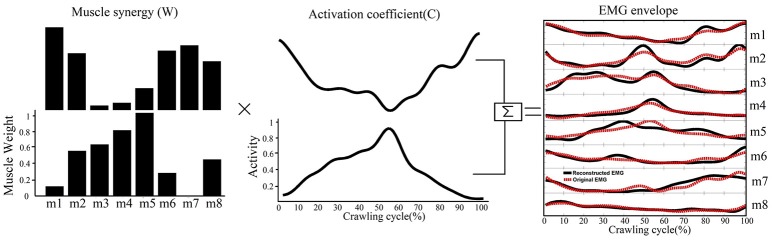
A schematic illustrating how muscle synergies are linearly combined to generate muscle patterns recorded as EMG signals. Each of the two muscle synergies (W) shown is represented as an activation weight across muscles (i.e., m1–m8) and activated through multiplication by a time-dependent coefficient(C). The EMG envelopes resulting from the activations of individual synergies are then summed together (black lines) to reconstruct the recorded EMG (red dashed line).